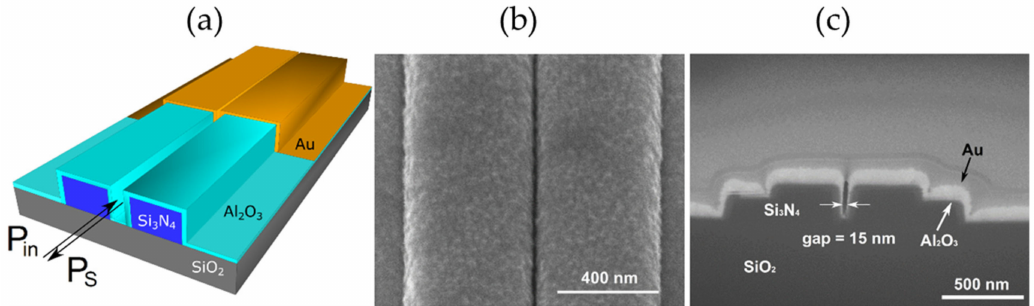
Figure 5. Nanoplasmonic slot waveguide. ( a ) Schematic showing that the input and Stokes powers are guided by the waveguide. ( b ) Scanning electron microscope image of the gold-covered slot in top view. ( c ) Cross-section of a nanoplasmonic slot waveguide with a gap of 15